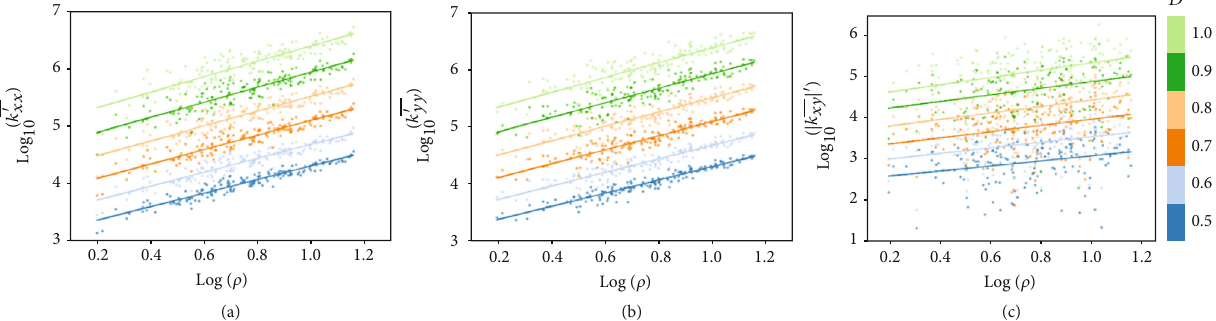
Figure 8: The average dimensionless permeability components of the equivalent fracture models versus dimensionless density of the discrete fracture models for varied aperture-length correlation exponent D